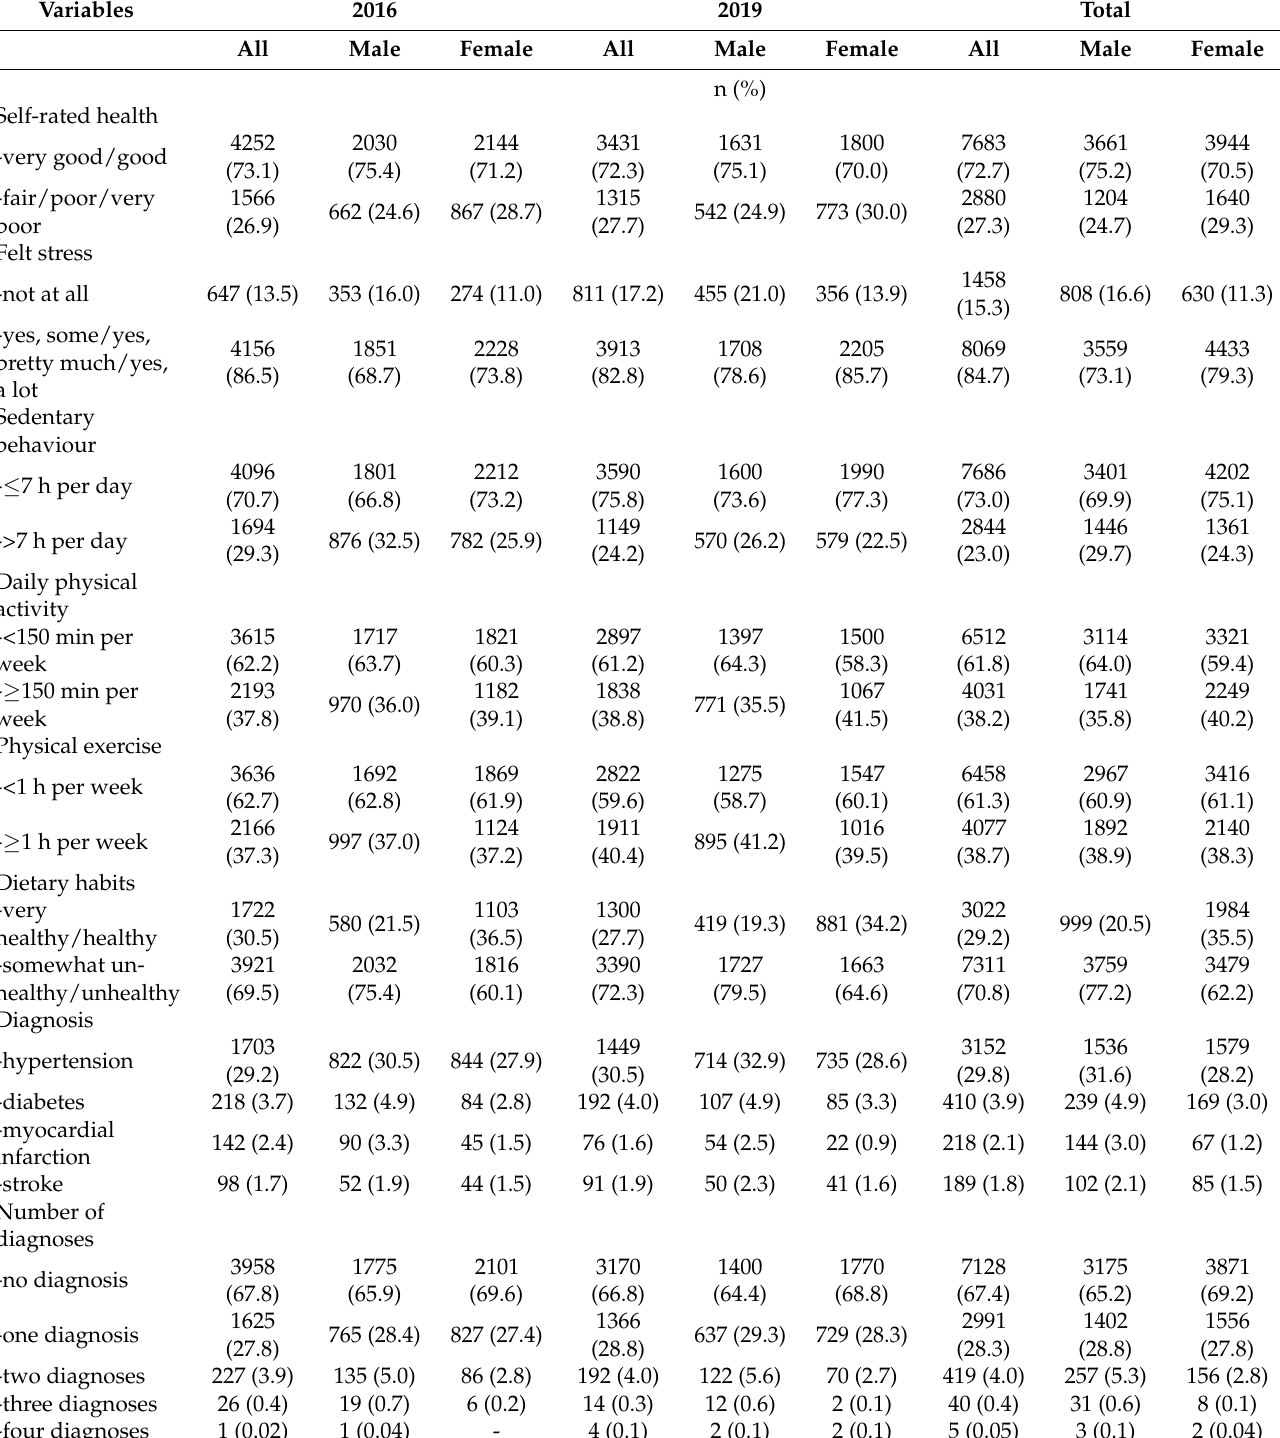
Table 2. Distribution of responses in the two data sets (2016, 2019) and in the total